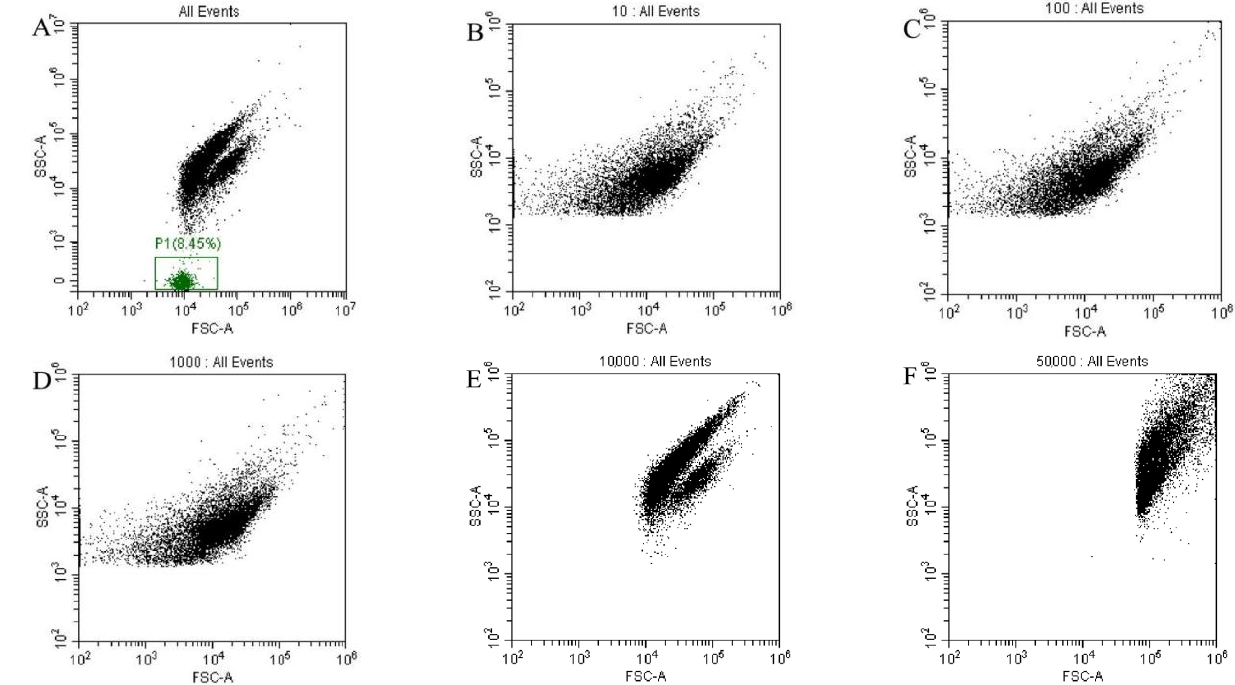
Figure 5. Application of different thresholds for FSC channel. ( A ) When a signal channel (FSC or SSC) was used for data collection. ( B – F ) FSC set to ( B ) 10; ( C ) 100; ( D ) 1000; ( E ) 10,000; and ( F ) 50,000.